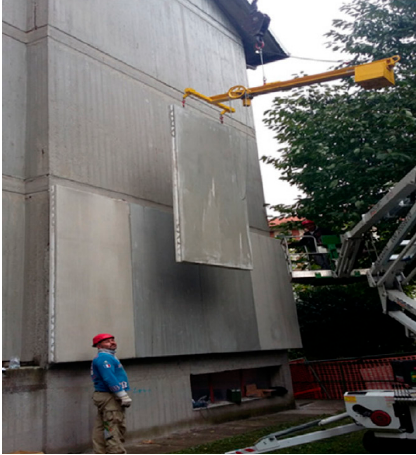
Figure 15. Installation of a prefabricated insulated element (i.e., EPS sandwiched between two layers of TRM) in a retrofit project in Italy (adopted from [43]).